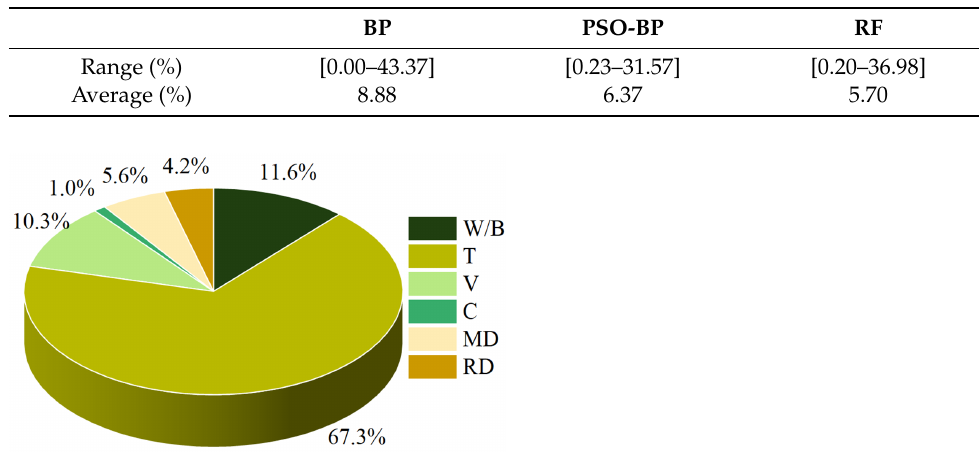
Figure 12. Importance of input parameters based on the RF